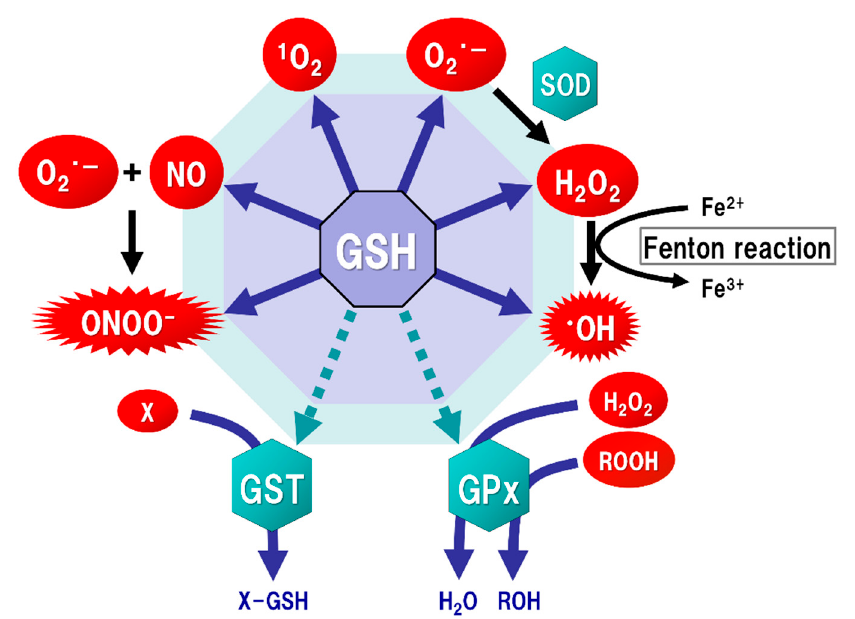
Figure 2. Function of glutathione (GSH) as an antioxidant. Mitochondria generate superoxide (O 2 · − ), which reacts with nitric oxide (NO) to form peroxynitrite (ONOO − ), a typical reactive nitrogen species (RNS) that is a potent inducer of cell death. O 2 · − is catalyzed to hydrogen peroxide (H 2 O 2 ) by the reaction of superoxide with superoxide dismutase (SOD). H 2 O 2 reacts with Fe 2+ (Fenton reaction) to form a highly oxidizing radical, hydroxyl radical ( · OH). GSH can directly act as an antioxidant (solid arrows) by non-enzymatically reacting with NO, singlet oxygen ( 1 O 2 ), O 2 · − , H 2 O 2 , · OH, and ONOO − . GSH can also indirectly serve as an enzyme cofactor for detoxification (dotted arrows). H 2 O 2 is catalyzed to water and oxygen by GSH peroxidase (GPx), which requires GSH as an electron donor to react with H 2 O 2 and hydroperoxides (ROOH). GSH-S-transferase (GST) can detoxify various xenobiotics (X) via GSH conjugation to excrete toxic compounds from